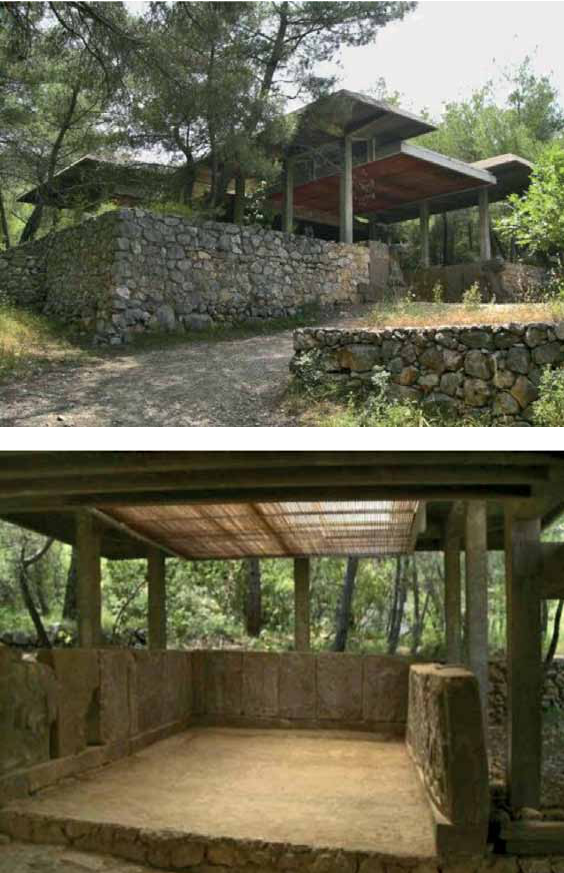
fig. 12. Karatepe